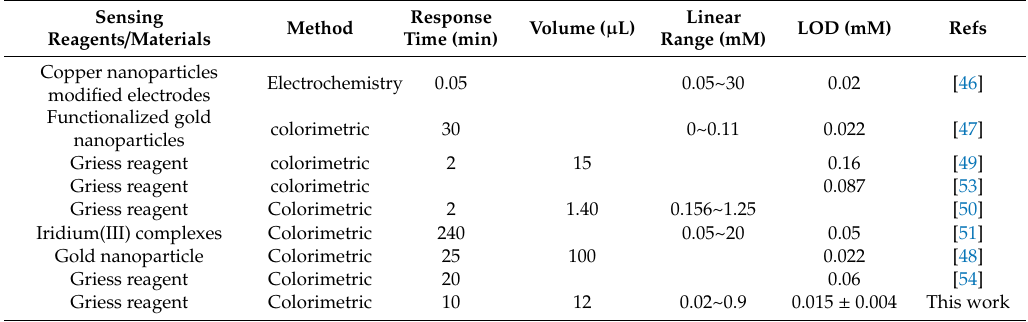
Table 1. Comparison of the parameters achieved for nitrite assay performed on sensors found in literature.